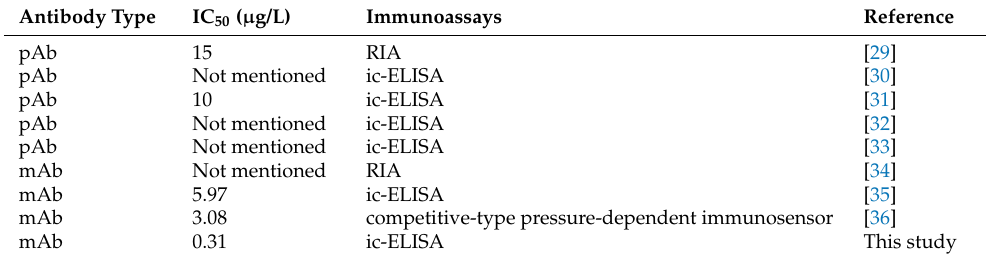
Table 1. Reported antibodies for determination of DAS.